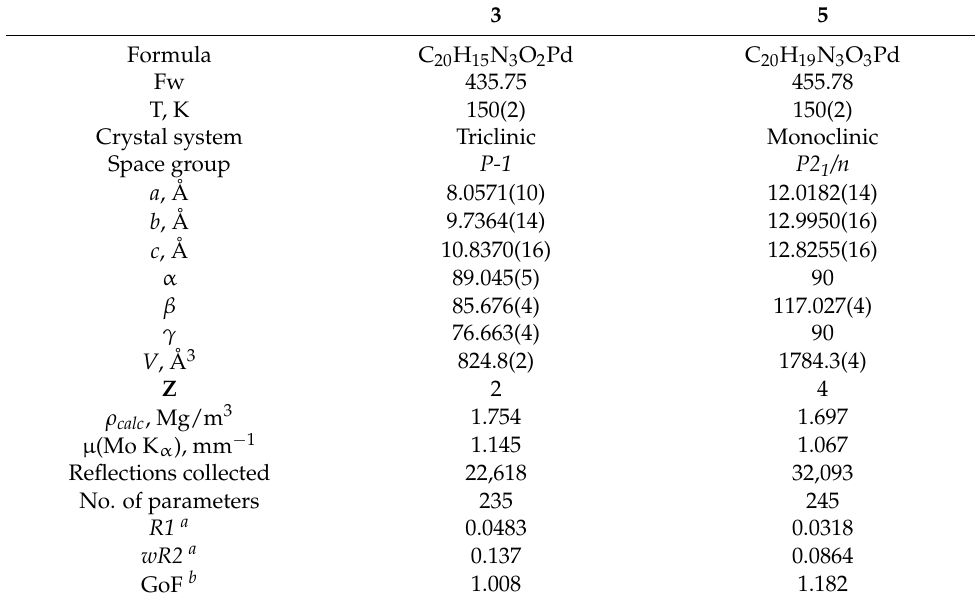
Table 3. Summary of crystal data for compounds 3 and 5